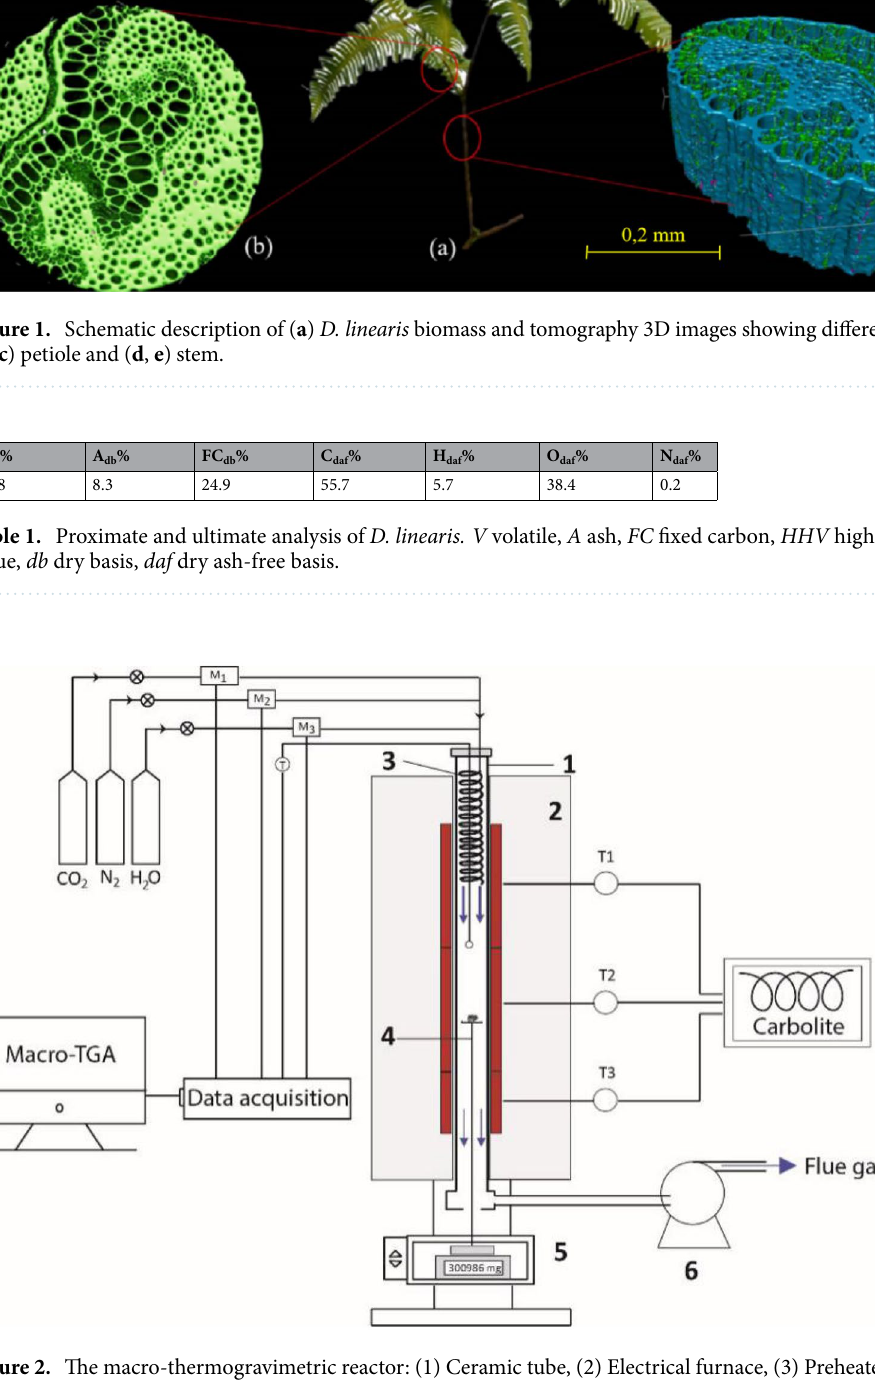
Figure 2. The macro-thermogravimetric reactor: (1) Ceramic tube, (2) Electrical furnace, (3) Preheater, (4) Sample holder, (5) Weighing scale, and (6) Gas